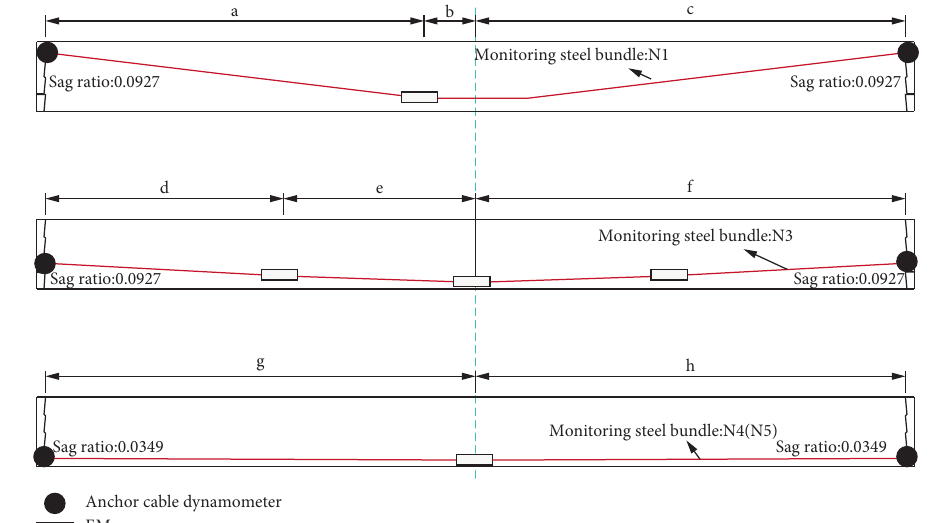
Sag ratio:0.0927